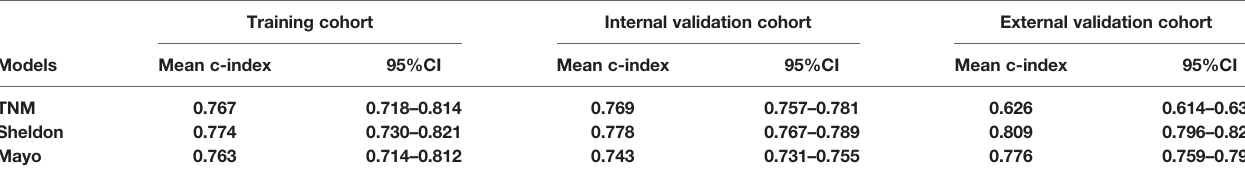
TABLE 2 | C-index of different nomogram